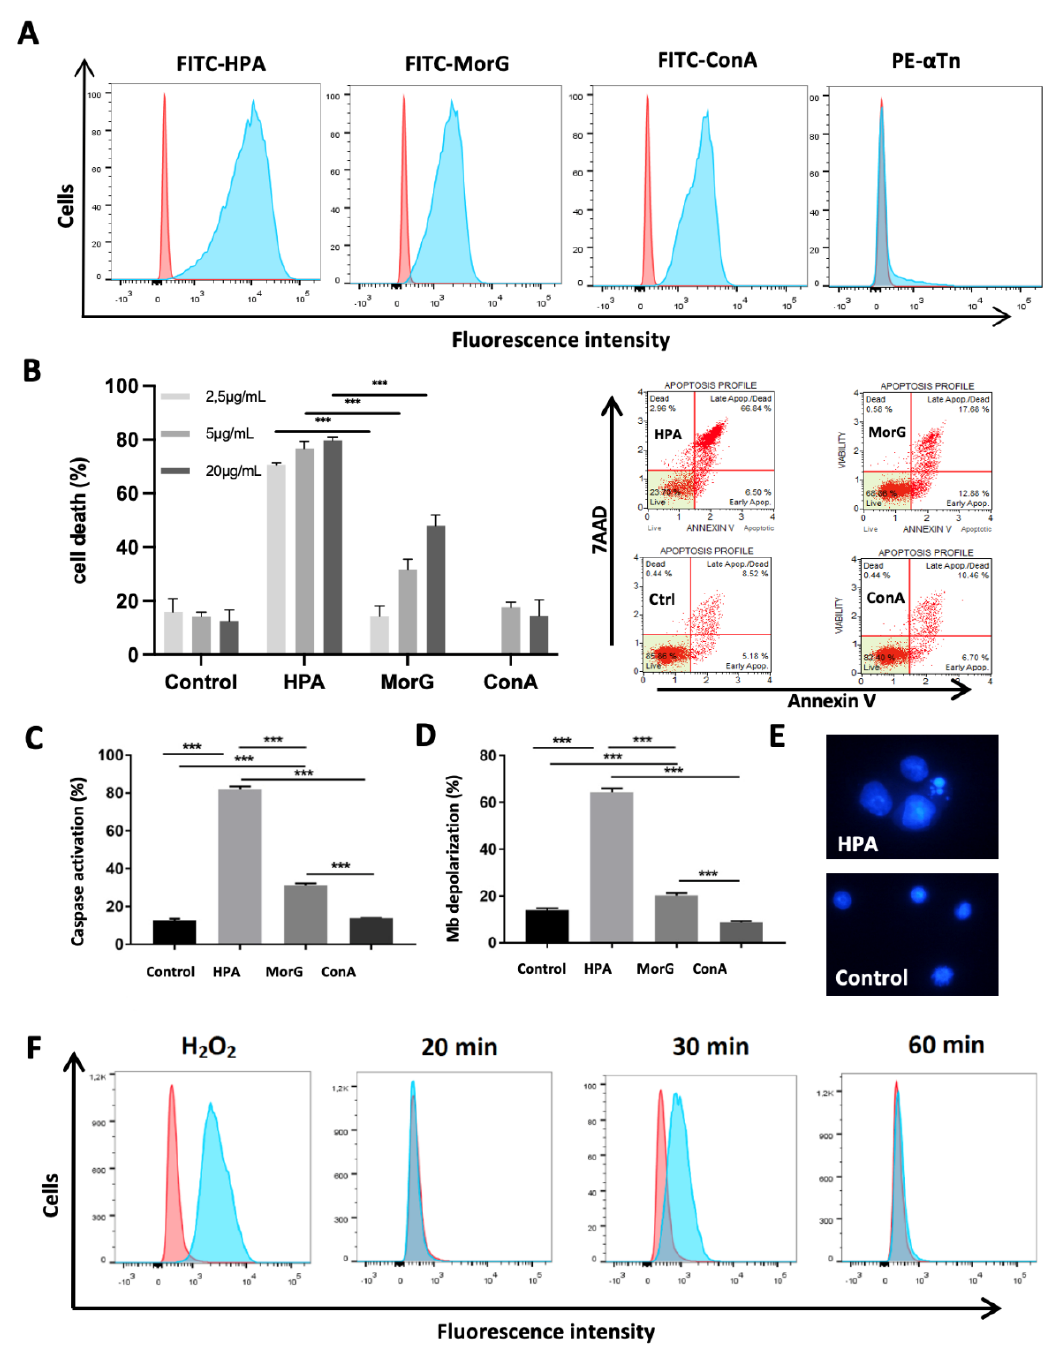
Figure 2. HPA induces cell death in mouse T-lymphoma cells: ( A ) EL4 lymphoma cells were incubated with anti-Tn mouse monoclonal antibody + PE anti-mouse antibody (PE- α Tn), FITC-conjugated HPA (FITC-HPA), FITC-conjugated Morniga G (FITC-MorG), or FITC-conjugated ConA (FITC-ConA) and analyzed using cytofluorimetry (Red curves indicate autofluorescence). ( B – D ) EL4 lymphoma cells were cultured for 48 h with different concentrations of HPA, MorG, and ConA and analyzed using cytofluorimetry: ( B ) cell viability evaluated with Annexin V/7AAD assay (on the right, representative experiment), ( C ) caspase activation, and ( D ) mitochondrial membrane depolarization ( C , D , lectin 5 µ g/mL). ( E ) Cellular morphology was observed after DAPI staining and using fluorescent microscopy, representative of three independent experiments. ( F ) EL4 cells were incubated for 20–50 min with 20 µ g/mL HPA. Next, reactive oxygen species production was evaluated at different times using dihydroethidium assay in cytofluorimetry, as compared with H 2 O 2 treatment (0.1 mM, 20 min). ( B – D ), results are means ± SD of at least three independent experiments. Significant differences are indicated (*** p <